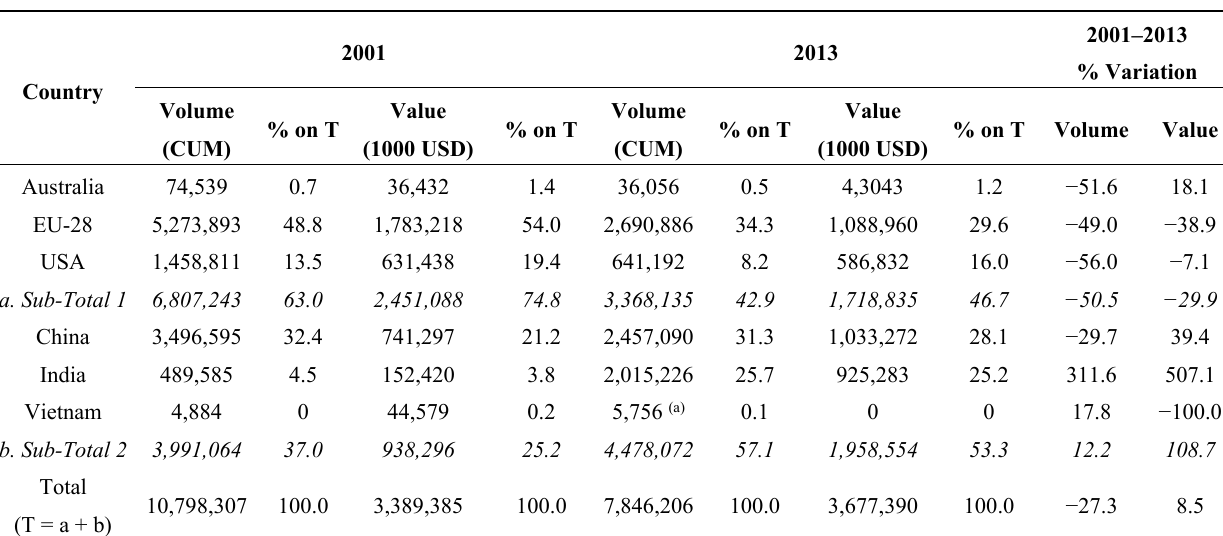
Table B1. Tropical timber product imports by selected countries, 2001 and 2013.